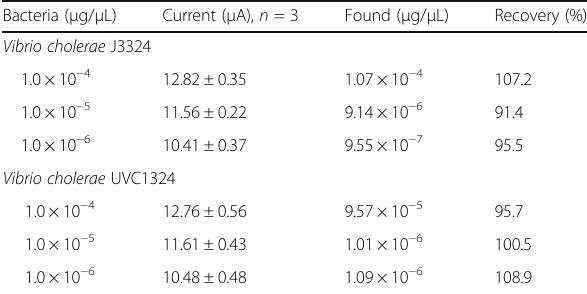
Table 4 Recovery of V. cholerae J3324 and V. cholerae UVC1324 DNAs by using the proposed PSA-AuNPs-based